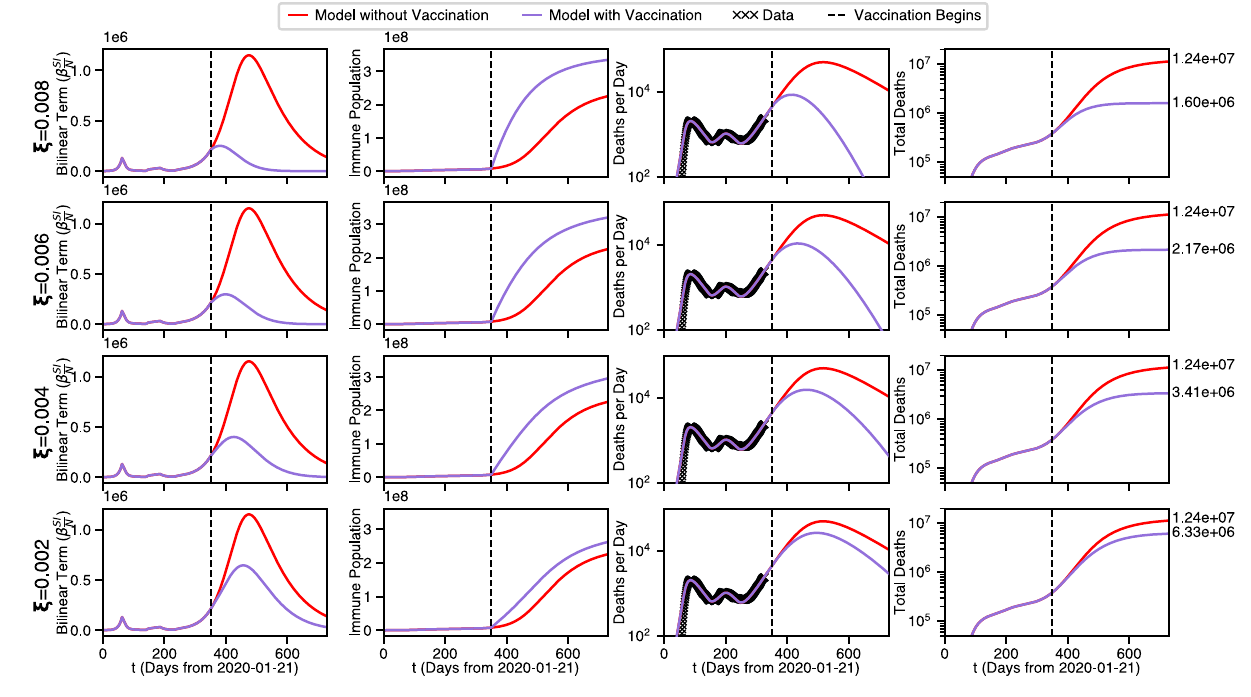
Figure 7. Four possible vaccination strength scenarios.